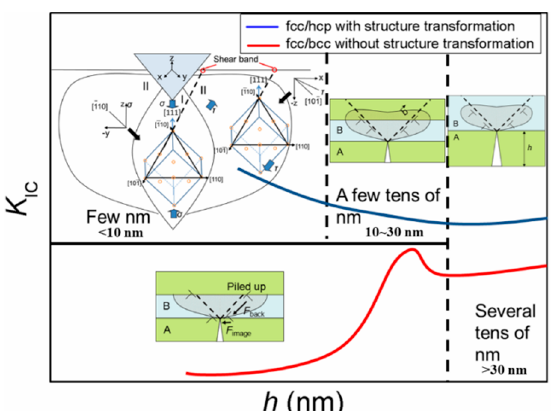
Figure 17. Evolution of fracture toughness with h for fcc/hcp multilayers with structure transformation and fcc/bcc without structure transformation. The figure demarcates regimes that exhibit distinct processes governing the crack and fracture phenomenon in this two multilayer systems. The sketches of the micro-mechanical fracture model, which shows the interface shielding effect, is presented in each region for clarity [15].